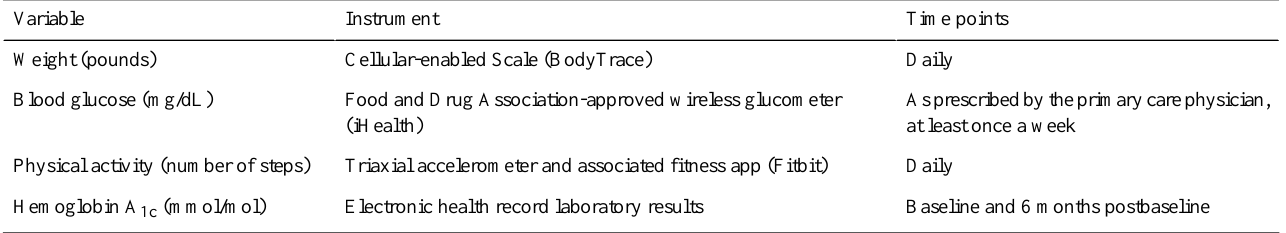
Table 1. Mobile health devices used and time points for data